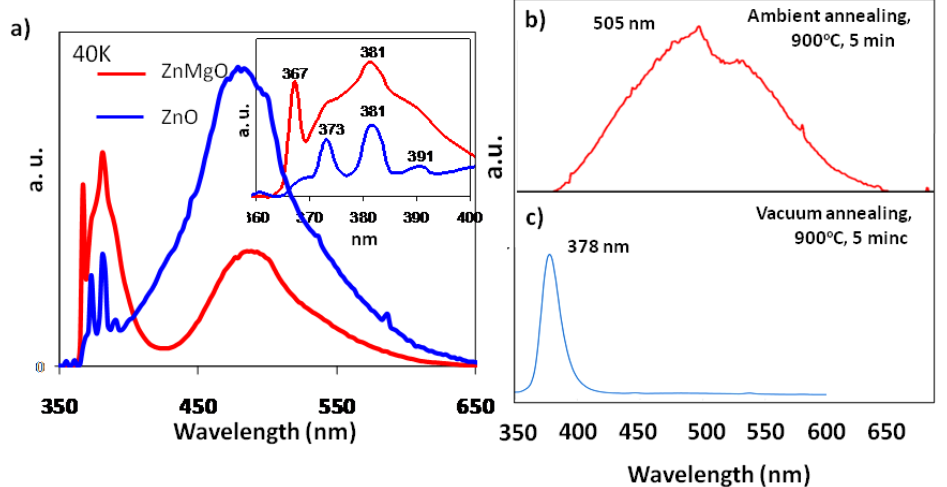
Figure 5. A set of photoluminescence spectra corresponding to: ( a ) as-prepared solution processed ZnMgO nanowire arrays measured at 40 K; ( b ) 900 °C ambient annealed ZnMgO nanowires measured at room temperature; ( c ) 900 °C vacuum (1 × 10 − 2 torr.) annealed ZnMgO nanowires measured at room